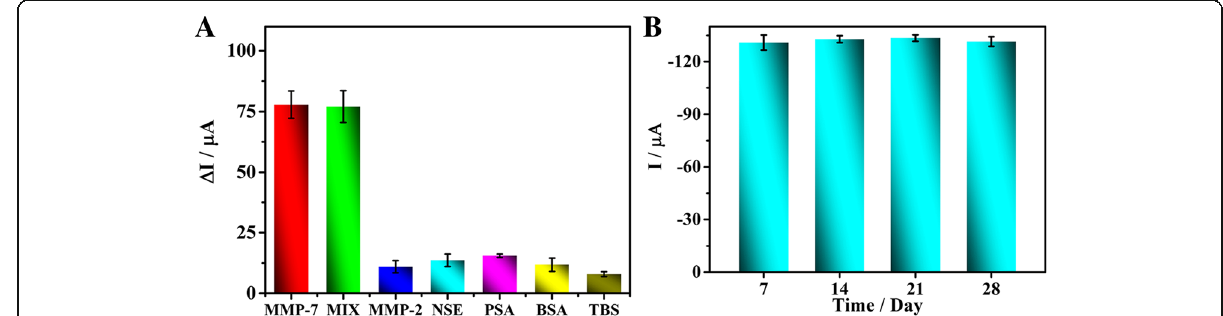
Fig. 7 SWV current responses ( a ) about anti-interference ability of the biosensor (the error bars are standard deviations for n =3). The concentrations of distractions: MMP-2 (100 ng mL − 1 ), NSE (100 ng mL − 1 ), PSA (100 ng mL − 1 ), THR (100 ng mL − 1 ) and BSA (100 ng mL − 1 ), respectively. The mixture contains all those distractions (100 ng mL − 1 ) and MMP-7 (1 ng mL − 1 ). SWV responses ( b ) of the proposed biosensors stored at 4 °C for different time for the detection of 1 ng mL − 1 MMP-7